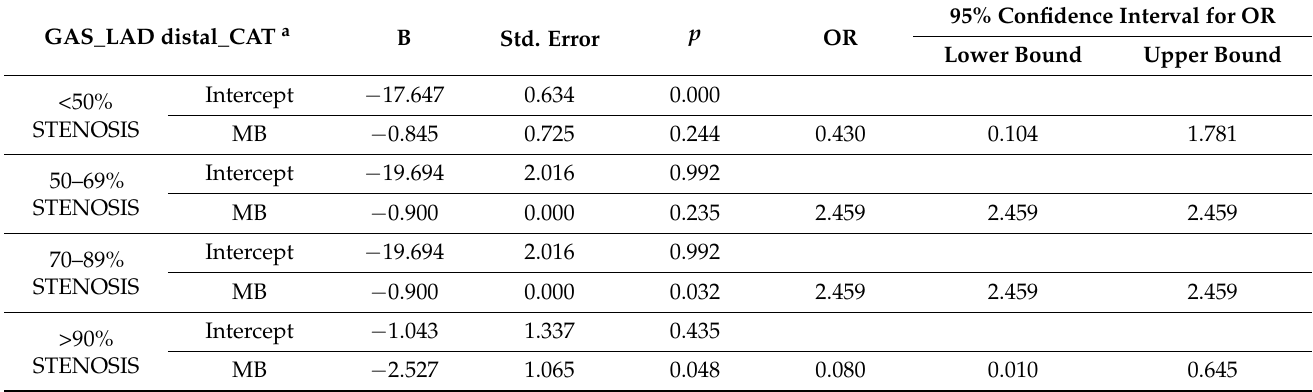
Table 7. Regression model for the probability of atherosclerotic stenosis on the distal segment of left anterior descending artery in the presence of myocardial